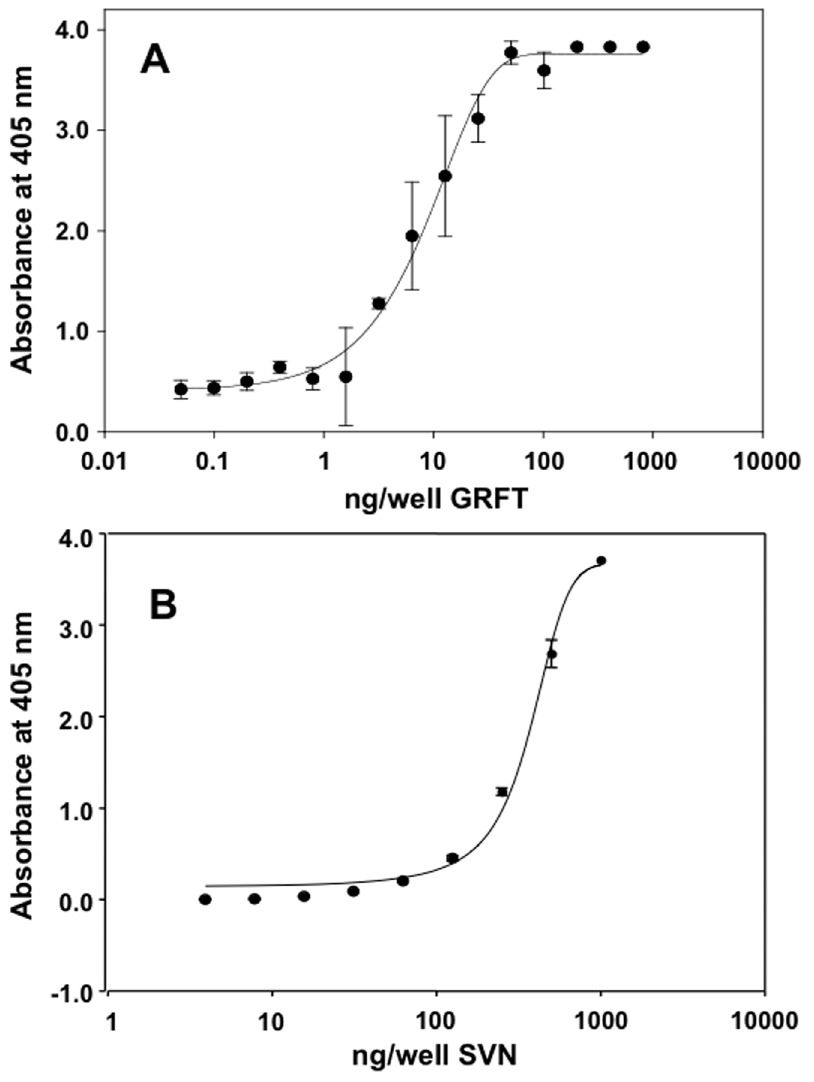
Figure 5. GRFT and SVN bind to HCV E2 glycoprotein. Recombinant glycosylated HCV envelope glycoprotein E2 (strain H77 1a) was bound to 96-well plates and exposed to varying concentrations of both SVN and GRFT. The presence of SVN (A) and GRFT (B) was visualized using rabbit polyclonal anti-GRFT or anti-SVN antibodies as described in the Materials and Methods section. Data points represent the mean of three experiments 6